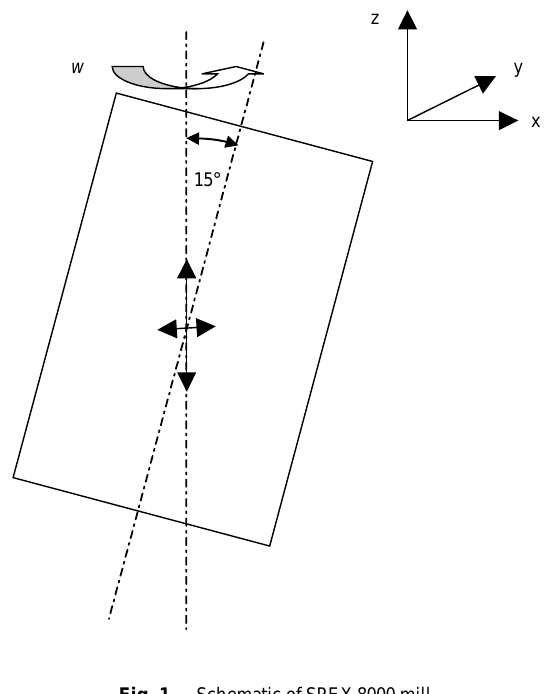
Fig. 1 Schematic of SPEX 8000